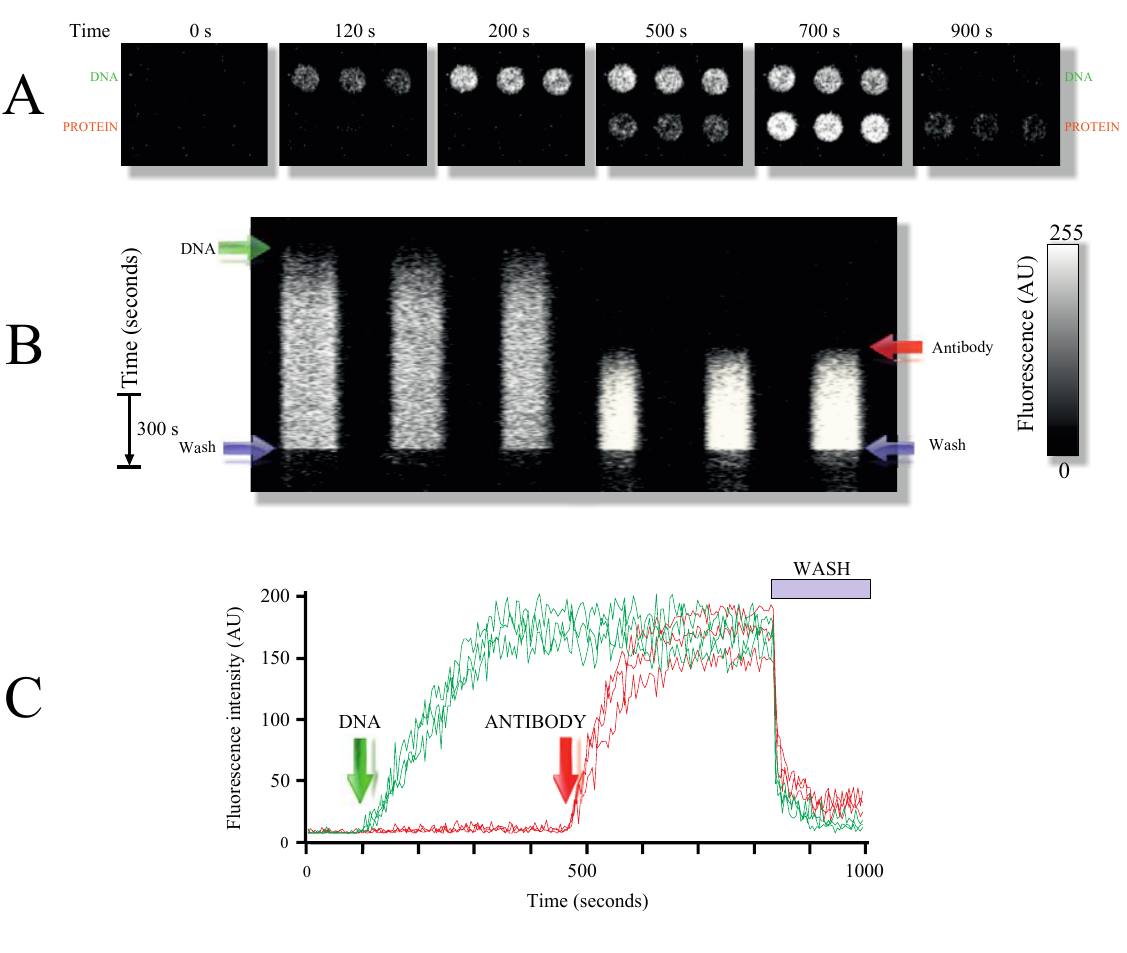
Figure 3. Combined DNA and protein microarrays on the same slide. ( A ) Example of a typical response obtained in a combined microarray using DNA and antibodies. The three spots at the top are molecular beacons for pag and the three bottom spots of Immunopure™ biotinylated mouse anti-human IgG. ( B ) Time course of the microarray response to bioanalyte solutions. First DNA from pag was applied (green arrow), followed by the secondary antibody (Alexa Fluor 532-labeled goat anti-mouse IgG, red arrow). Notice that even though the secondary antibody floods the entire chamber, only the spots containing the primary antibody produced a fluorescent signal. This simple experiment demonstrates the power of surface selectivity obtained with LG-TIRFM-MB. Microarray reconstitution brings the fluorescence towards baseline (pre stimulation) levels. At the right of the figure is shown the fluorescence intensity scale. ( C ) Lines depict time courses showing changes in mean fluorescence of each spot over time. Time points where DNA and antibody were applied are indicated by the arrows.